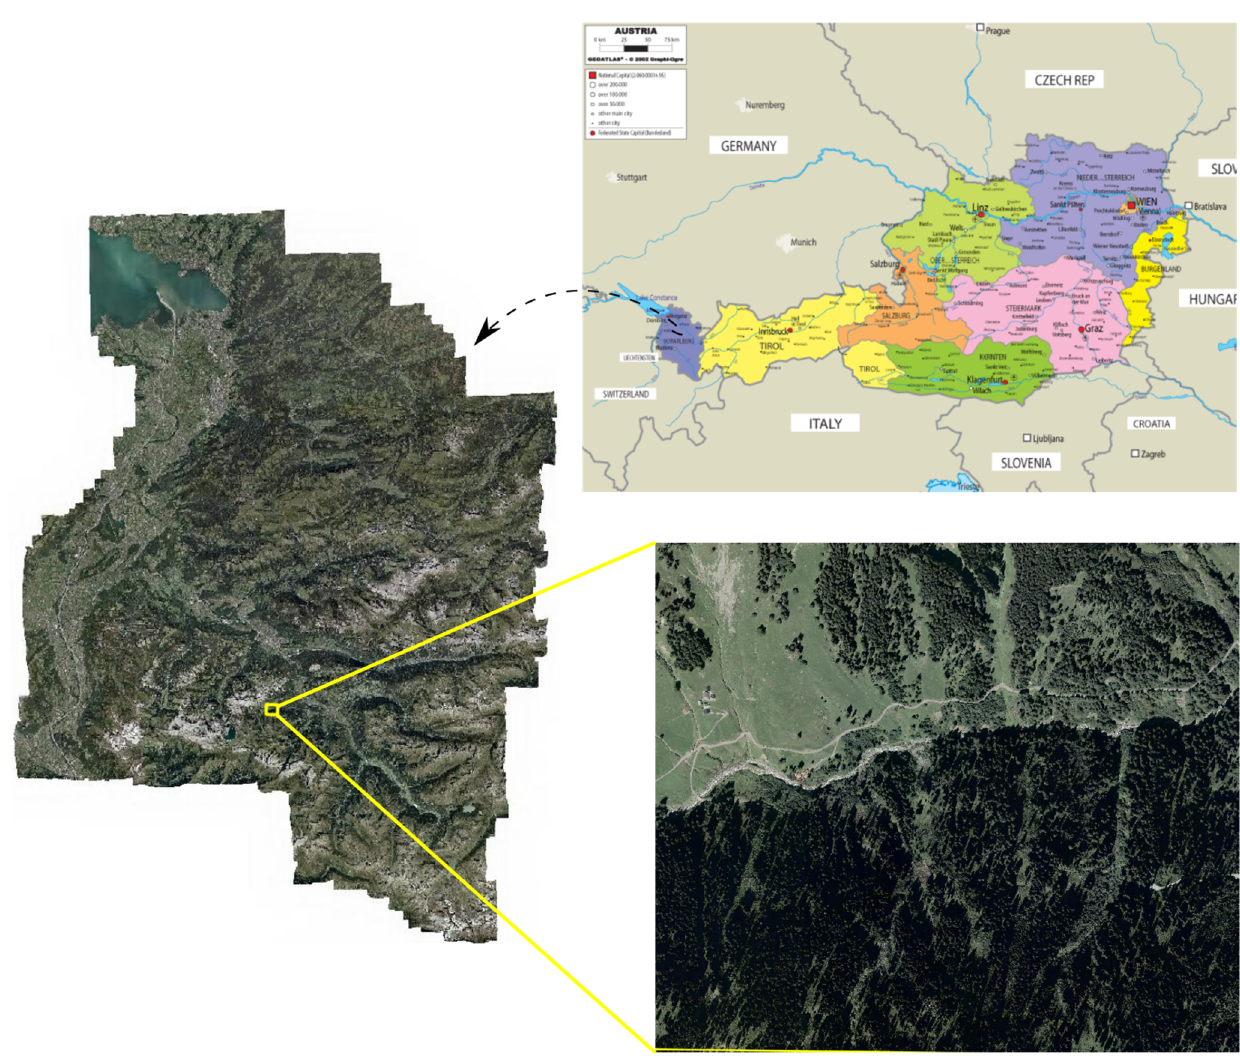
Figure 1. Study area (Orthophoto: office of survey and geoinformation from Vorarlberg, Austria, Political Map of Austria: